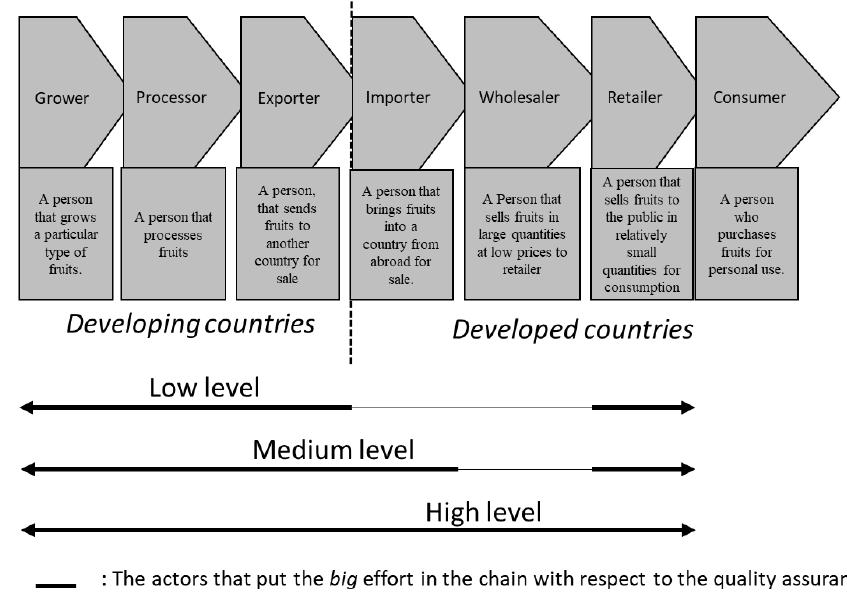
Figure 2. Degree of collaboration complexity of the chain.